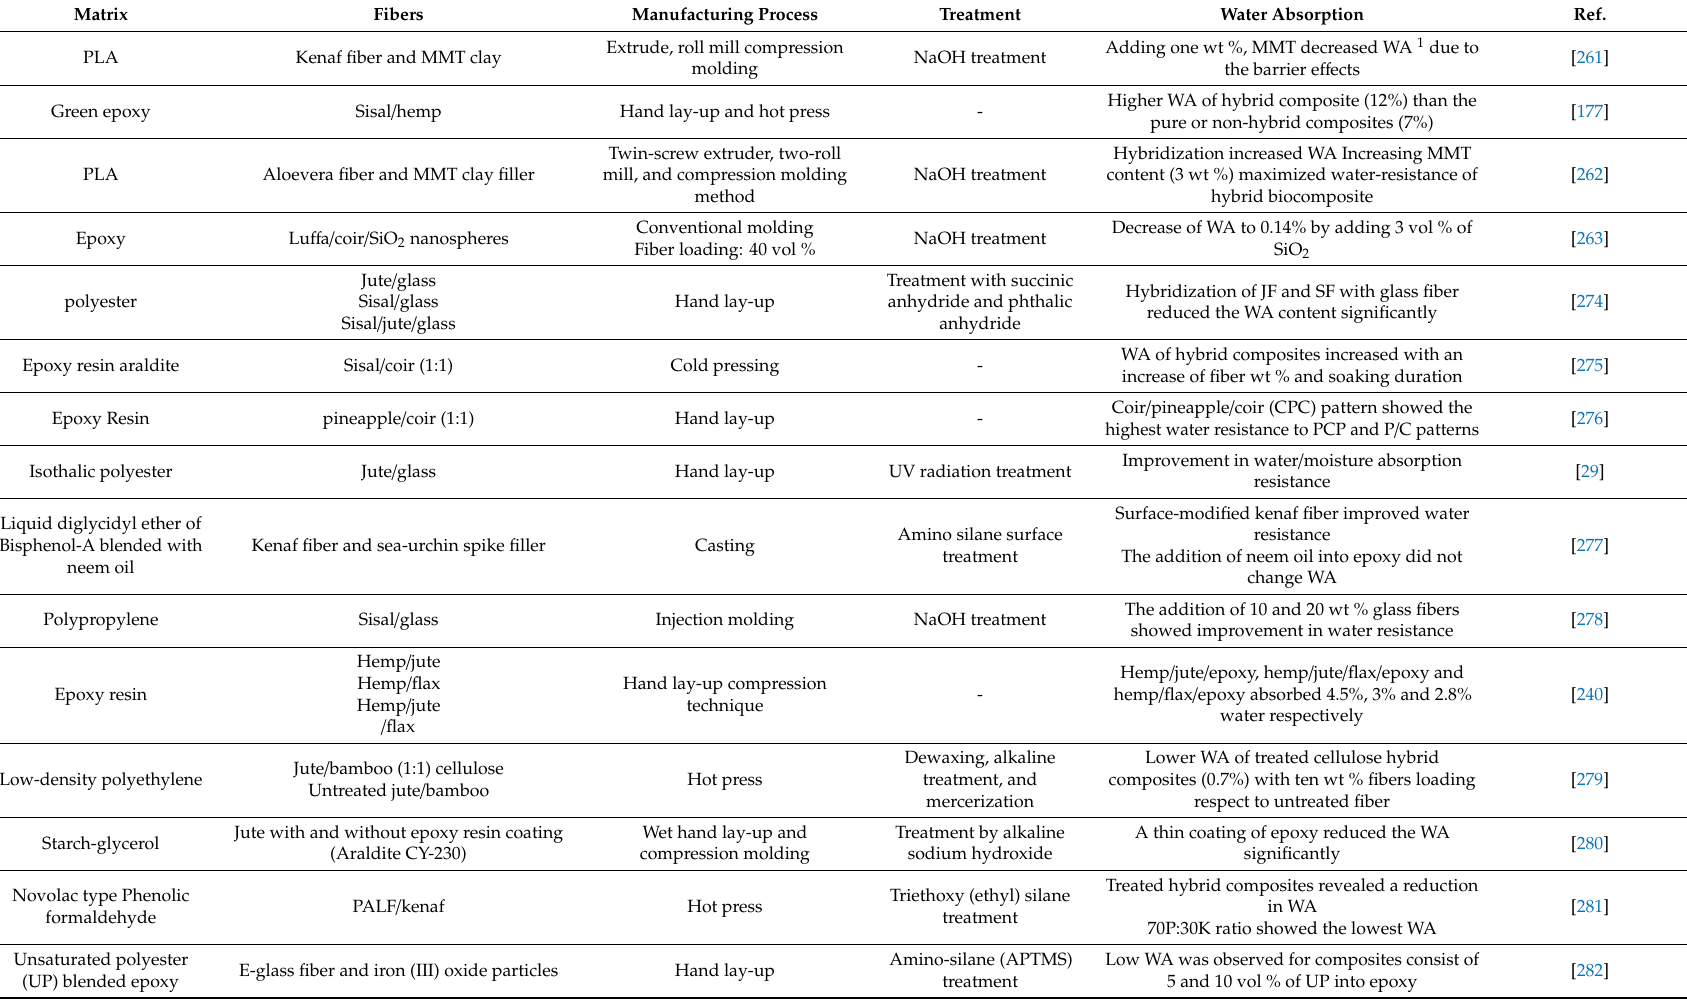
Table 7. Water absorption behavior of recently developed hybrid